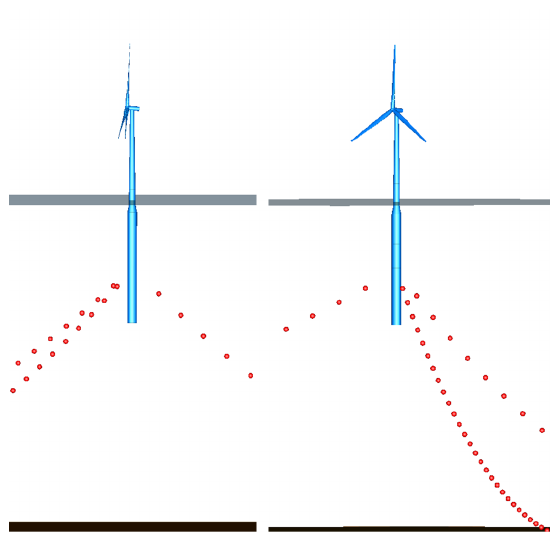
Figure 5. OC3 spar-buoy FOWT system modeled in MoWiT and visualized in Dymola; Reprint with permission [25]; 2017, Linköping University Electronic Press.